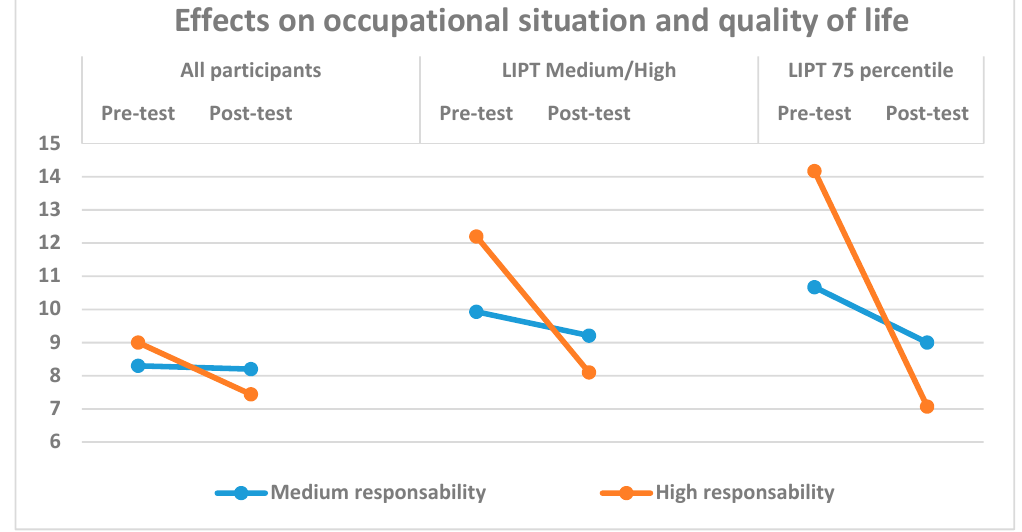
Figure 1. Intervention effects on occupational situation and quality of life in the experimental group.